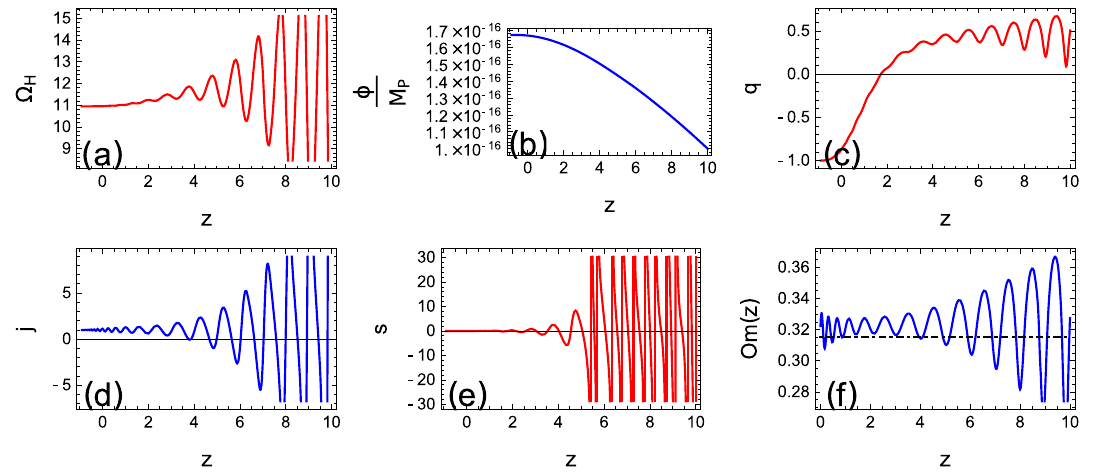
Fig. 4 The density parameter Ω H and scalar field φ over reduced Planck mass for the f ( R ) gravity with interaction considering η = 0 . 006 and α = 0 . 9. Other cosmological parameters are also plotted as functions of redshift parameter z Fig. 5 Variation of dark energy variables, the effective EoS parameter w ef f (right) and DE Density parameter Ω DE (left) with interaction considering η = 0 . 006 and α = 0 .